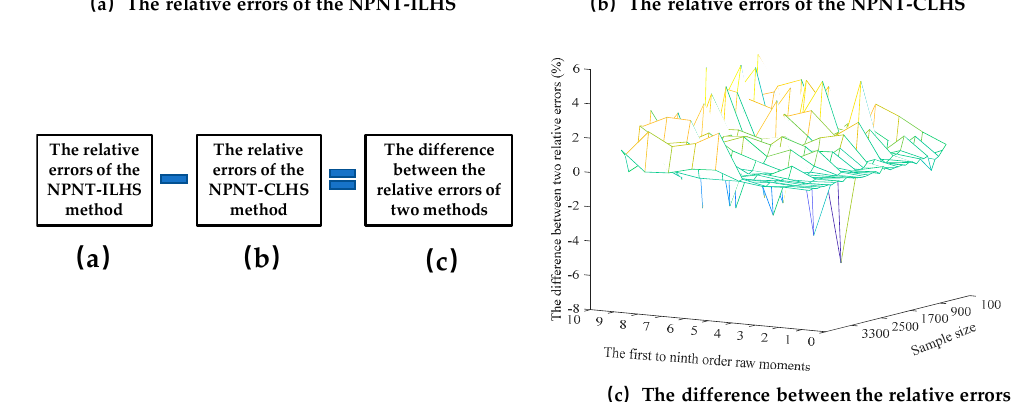
Figure 10. The computational time of NPNT-ILHS and NPNT-CLHS with gradually increasing sample points (the sample size is increased from 100 to 3800 at an interval 100).